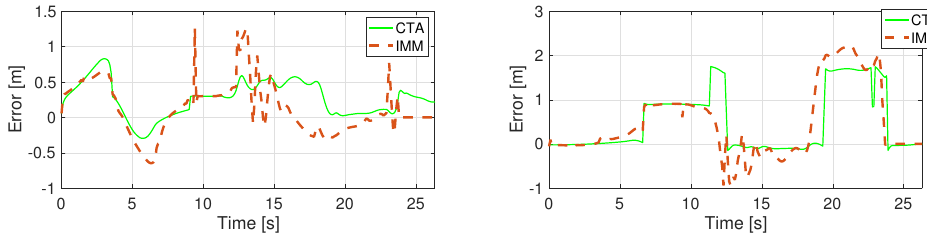
Figure 8. Position error in direction X ( left ) and Y ( right ) using the CTRA